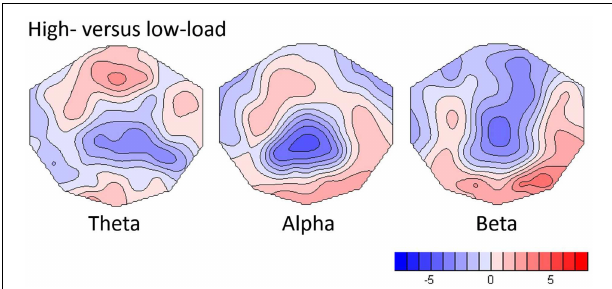
FIGURE 2 | T-maps showing load-dependent effects for theta, alpha and beta frequency bands. For the computation, the differences between high- and low-load conditions were normalized by the low load and t -tests against one were computed.